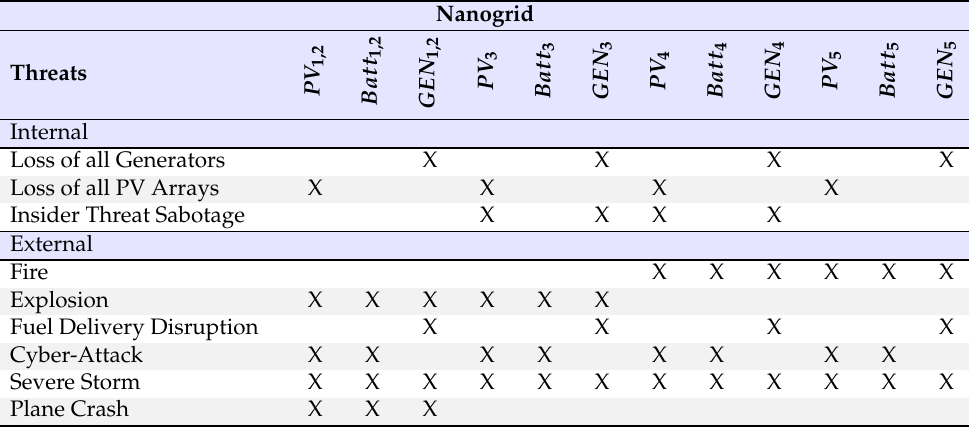
Table 7. Nanogrid Threat Scenarios. The nanogrid components that are offline, unavailable, or destroyed in each threat scenario are represented by an